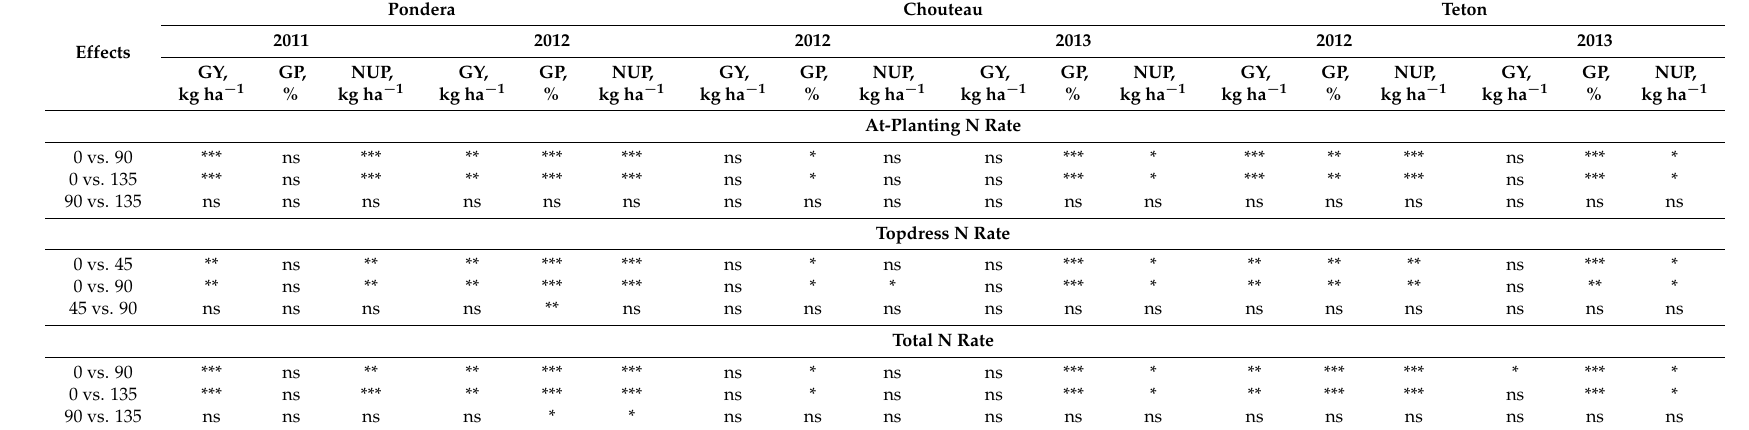
Table 1. Effect of at-planting N rate and topdress N rate on spring wheat grain yield (GY) and grain protein content (GP) for six site-years in